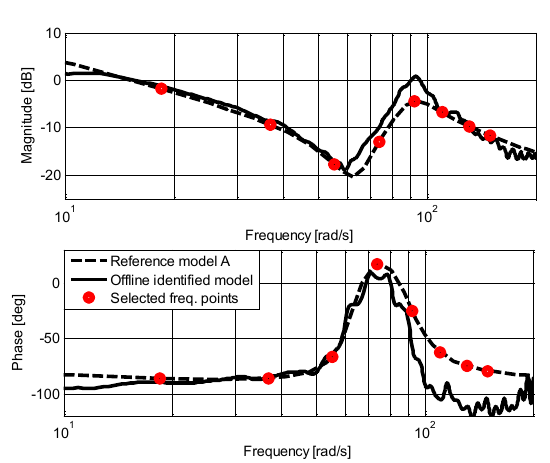
Figure 4: a) Offline-identified phase and magnitude response compared with the mathematical model (reference model A). The red dots are the selected frequencies to be monitored by the proposed online